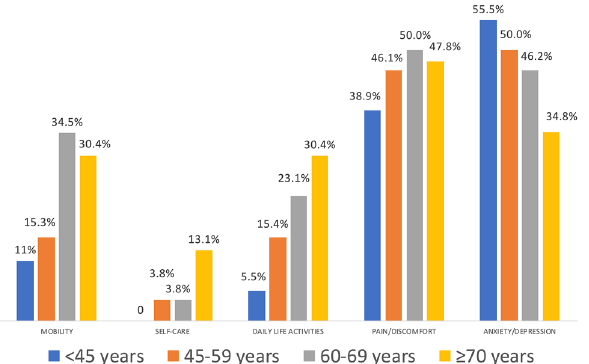
Figure 2. Distribution of the percentage of individuals exhibiting limitations on each domain of the EQ-5D-5L questionnaire by age